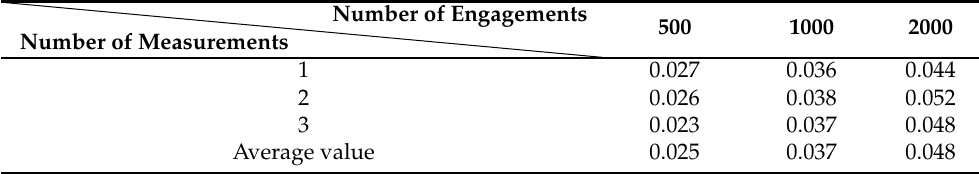
Table 3. Measurement results of the friction disk wear with three-way parallel grooves (unit: mm). Number of Measurements